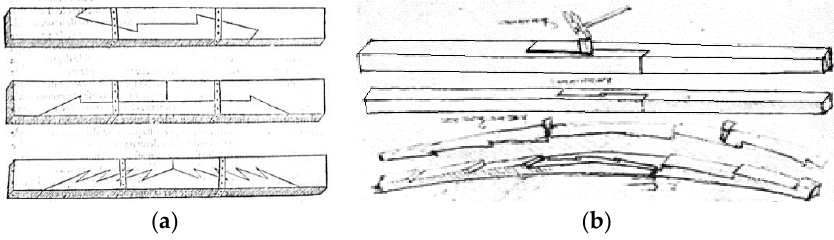
Figure 2. Sketches presenting scarf and splice joints in wooden beams ( a ) according to Leon Battista Alberti, ( b ) according to Leonardo da Vinci.